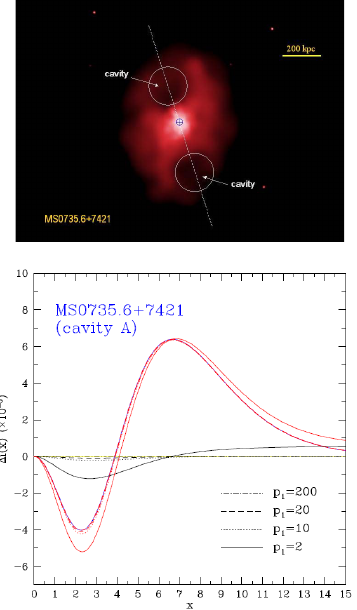
Figure 5: Top. The geometry of the cavities in the cluster MS0735.6+7421. Bottom. The SZE spectrum has been computed at a projected radius of ≈ 125 kpc from the cluster center where the LOS passes through the center of northern cavity. The thermal SZE (blue), the non-thermal SZE from the cavity (black) and the total SZE (red) are shown. The non-thermal SZE is nor- malized to the cavity pressure P = 6 · 10 − 11 erg cm − 3 , and is shown for various values of p 1 . Figure from